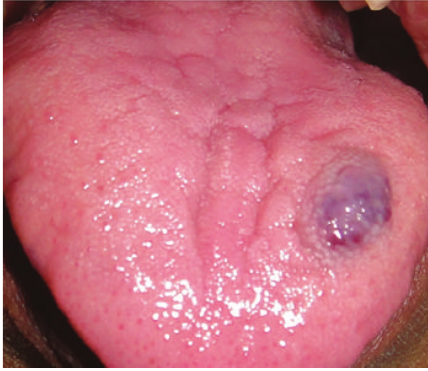
Figure 1: Preoperative photograph.